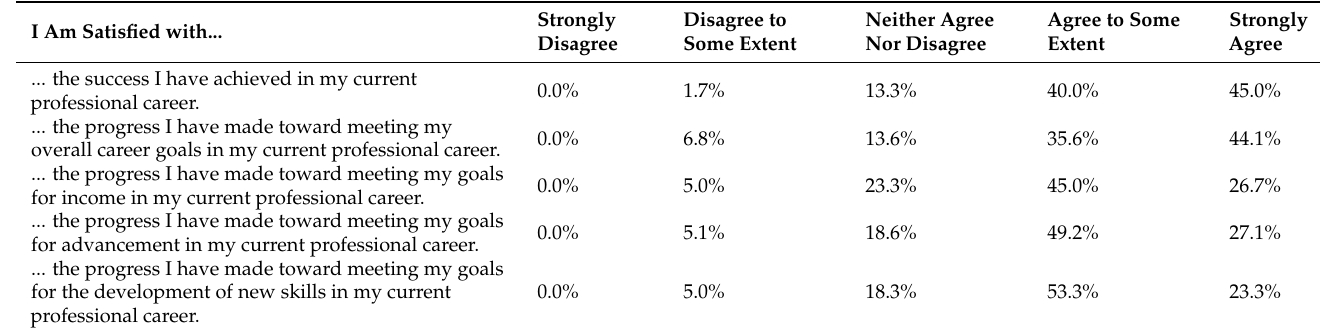
Table 3. Ex-soccer professionals’ satisfaction with their current professional career (n =